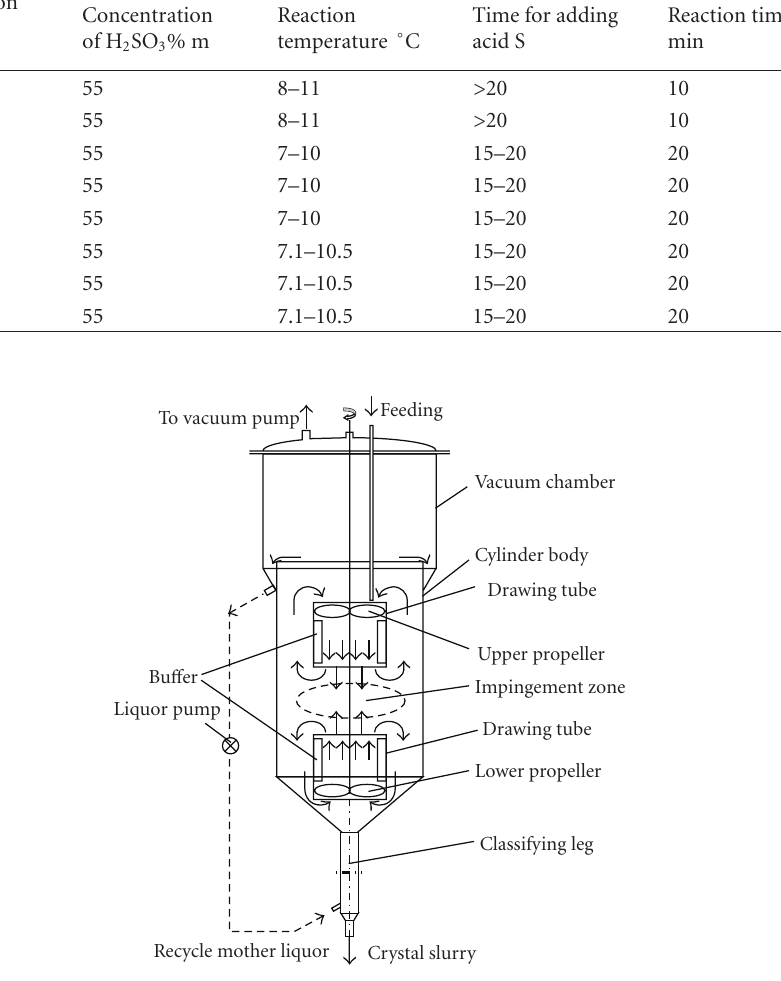
Figure 13: Non-rotating flow impinging stream